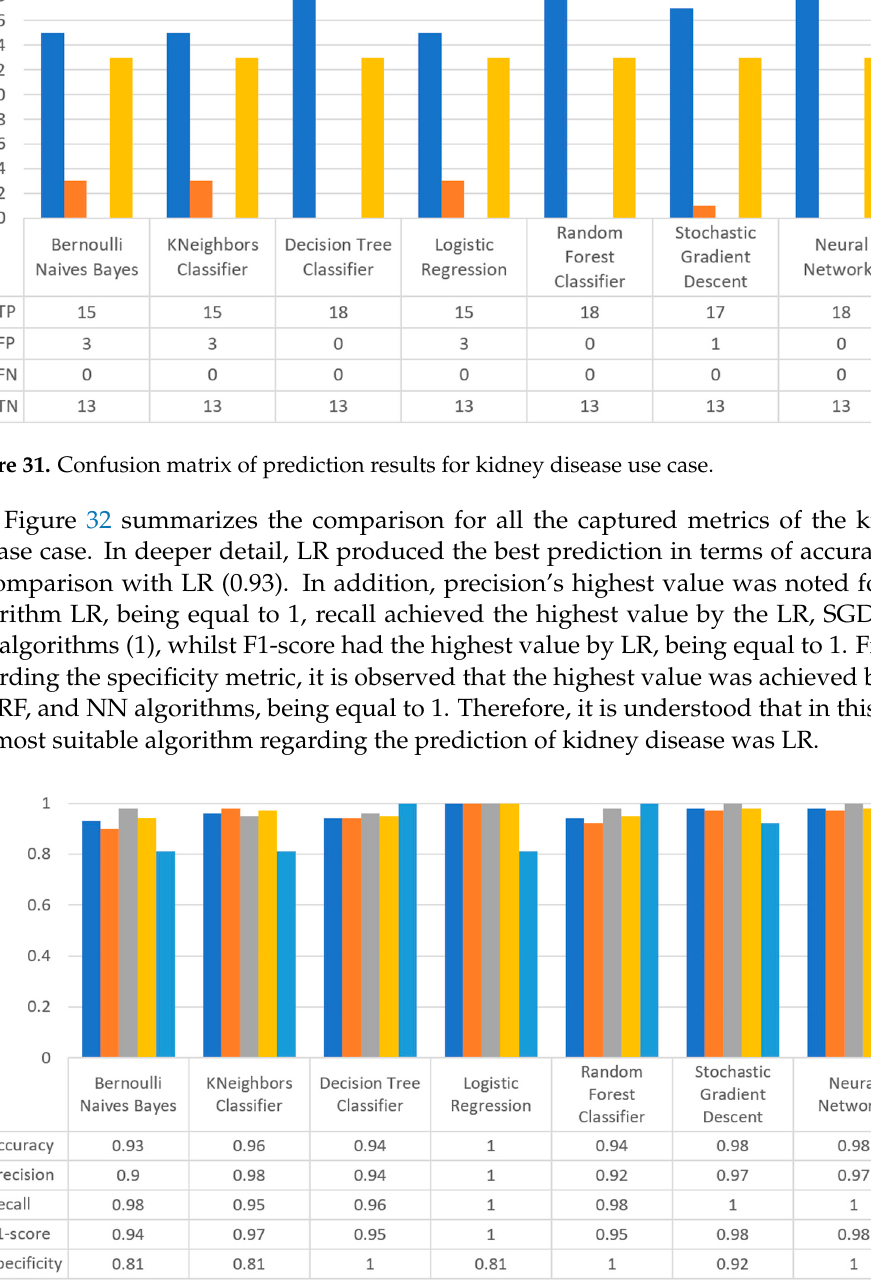
Figure 30. Train–validation–test score for kidney disease use case.